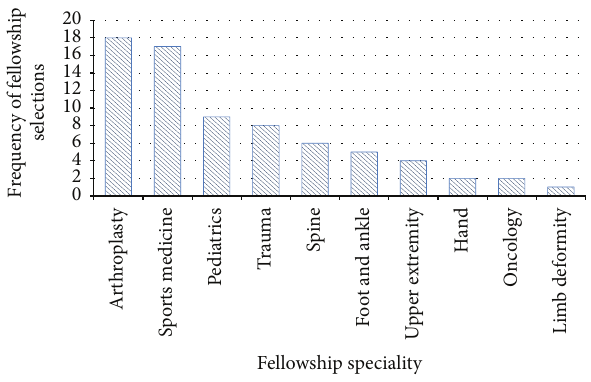
Figure 2: Fellowship pursuits among current PGY-4 and PGY-5 orthopedic residents. Graphic illustration of various frequencies of fellowship selections among current PGY-4 and PGY-5 Canadian orthopedic